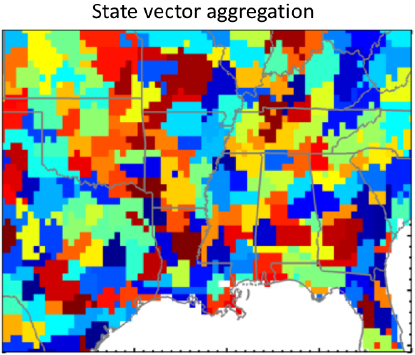
Figure 2. Approximate rendition of the reduced-dimension state vector of n = 216 elements used to constrain methane emissions in the Southeast US. This reduced-dimension state vector was ob- tained by projecting the 3456 GEOS-Chem grid cells at 0 . 25 ◦ × 0 . 3125 ◦ resolution onto a Gaussian mixture model (GMM) with radial basis functions (RBFs), as described in the text. The colors group together 0 . 25 ◦ × 0 . 3125 ◦ grid cells with the largest RBFs for a given Gaussian mode and have no other significance. This visu- alization of the state vector as a cluster with hard boundaries is an approximate rendition because each 0 . 25 ◦ × 0 . 3125 ◦ grid cell is in fact individually optimized as a superimposition of the 216 Gaus- sian modes with RBF